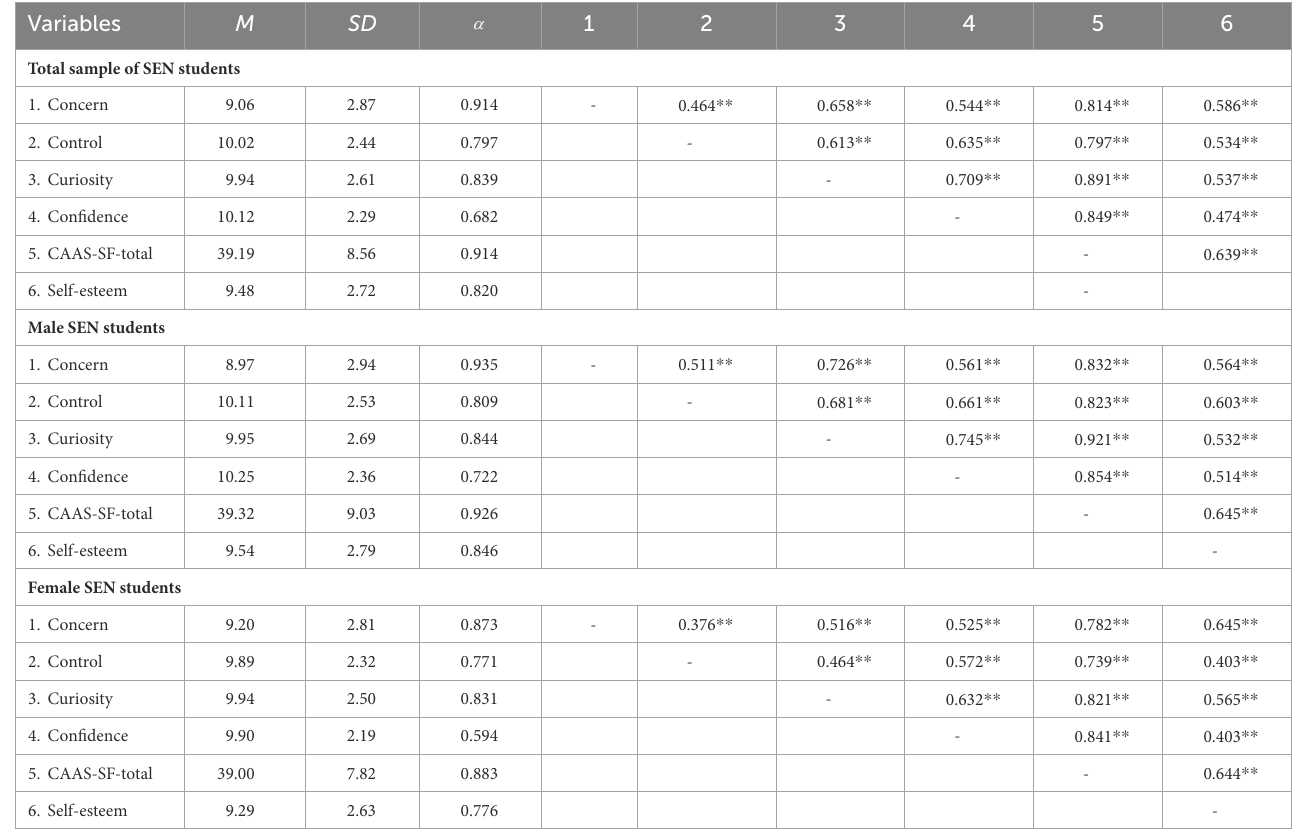
TABLE 1 Descriptive statistics and bivariate correlations of career adaptability and self-esteem. Variables